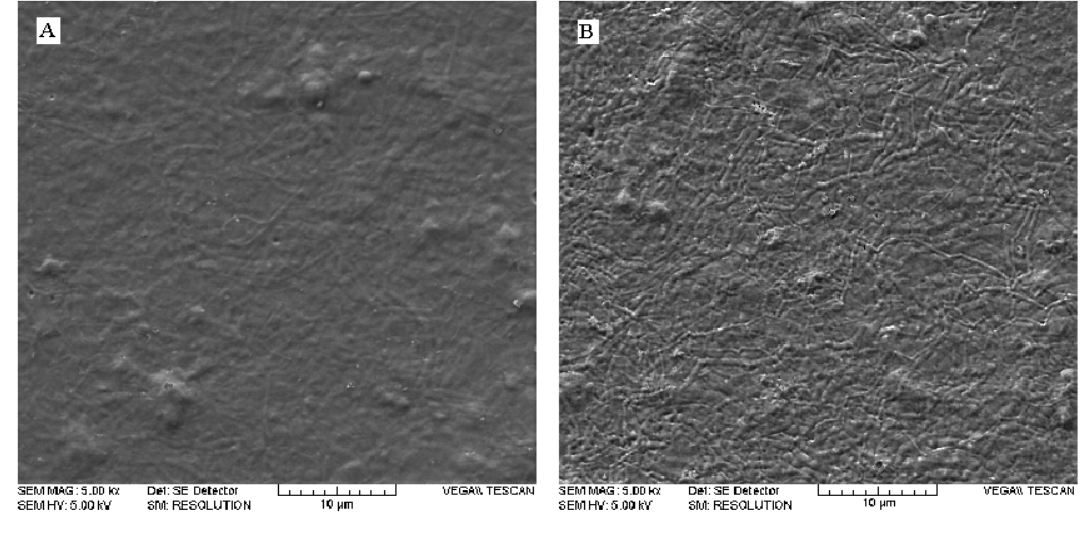
Figure 2. SEM surface topography of (A) untreated and (B) argon plasma-treated